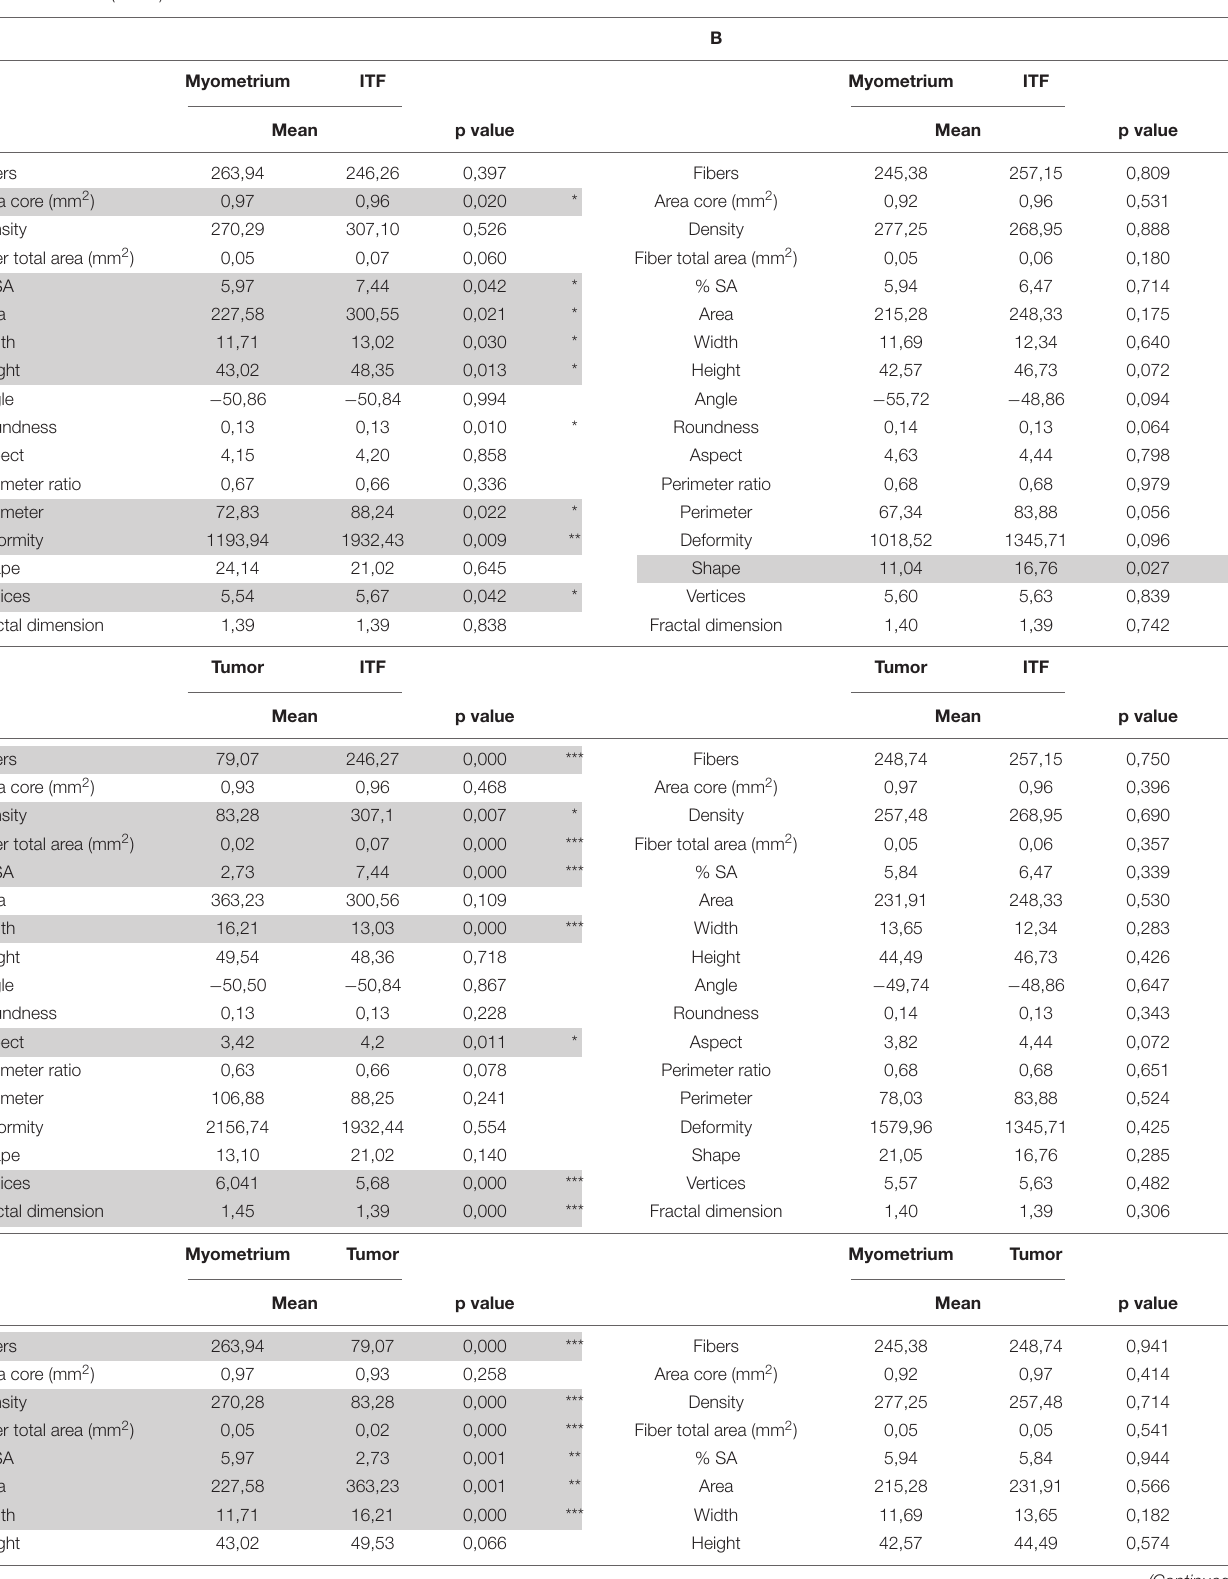
TABLE 1 | Heterogeneous architecture of reticular fibers between 1 × 1-mm regions of interest (ROIs) of tumor, myometrium, and invasive tumor front (ITF) within uterine adenocarcinomas (uADC).